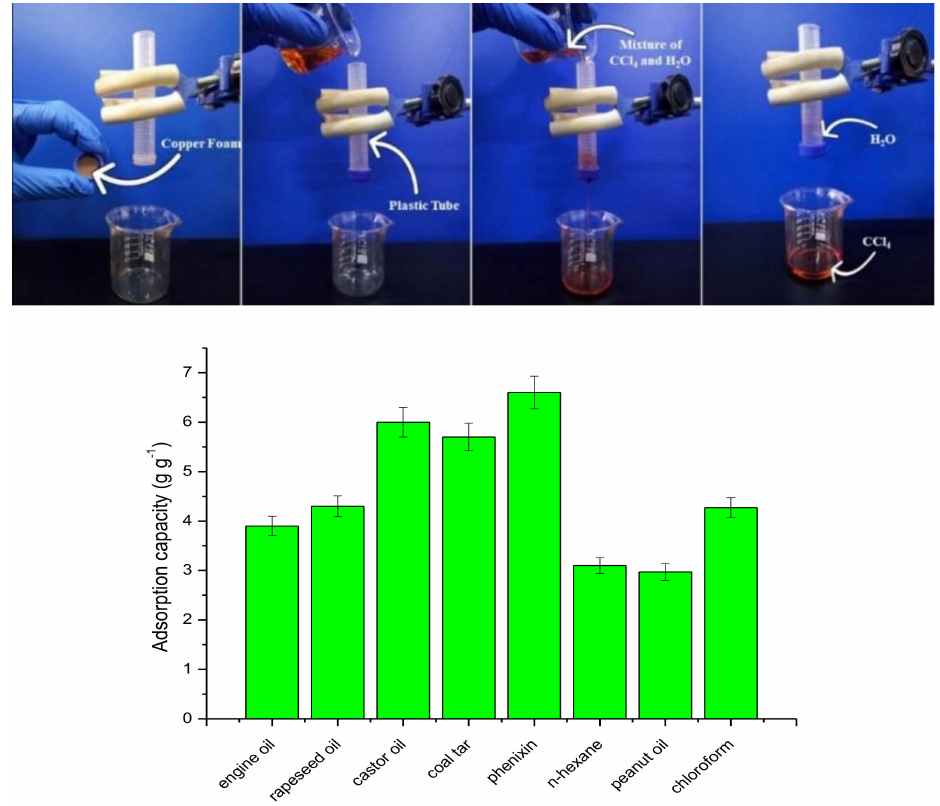
Figure 6. A photograph of the oil-water separation procedure ( upper ) and absorption capacity for different oils, such as gasoline engine oil, rapeseed oil, castor oil, coal tar, phenixin, n -hexane, peanut oil, and chloroform ( below